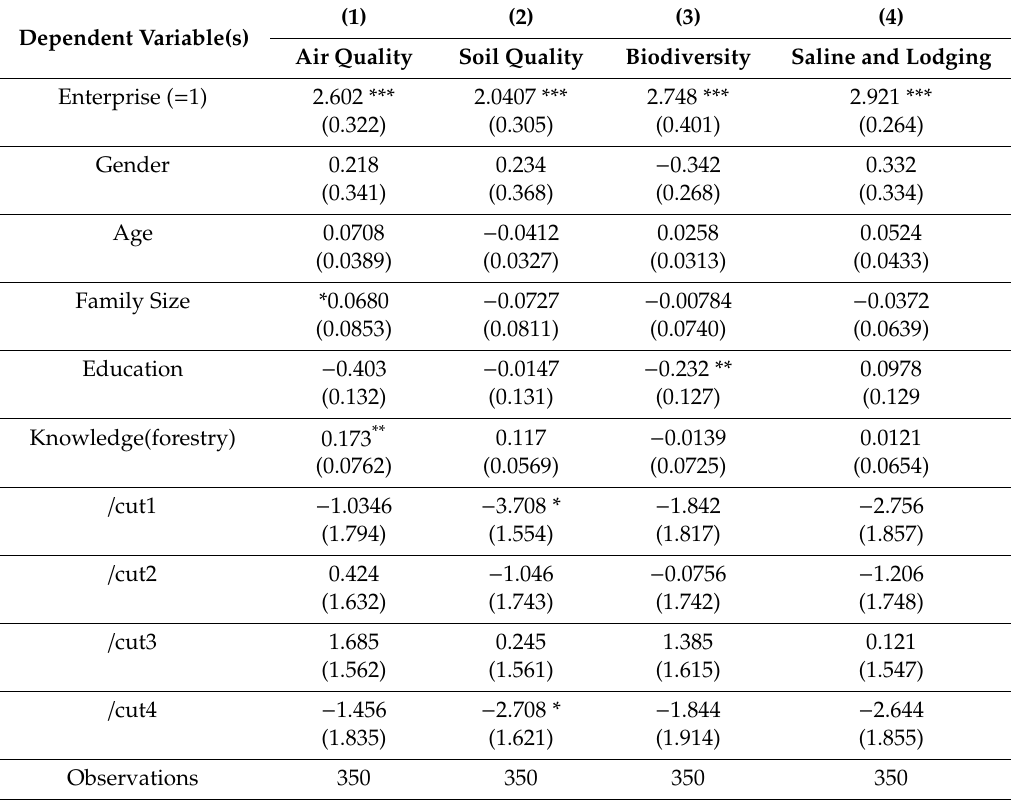
Table 9. BTAP and natural